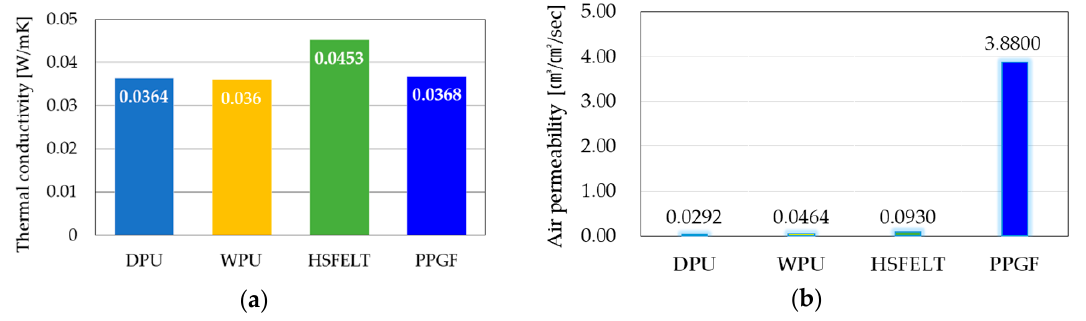
Figure 4. Comparison of thermal characteristics of each material considered: ( a ) Thermal conductivity; ( b ) Air permeability.